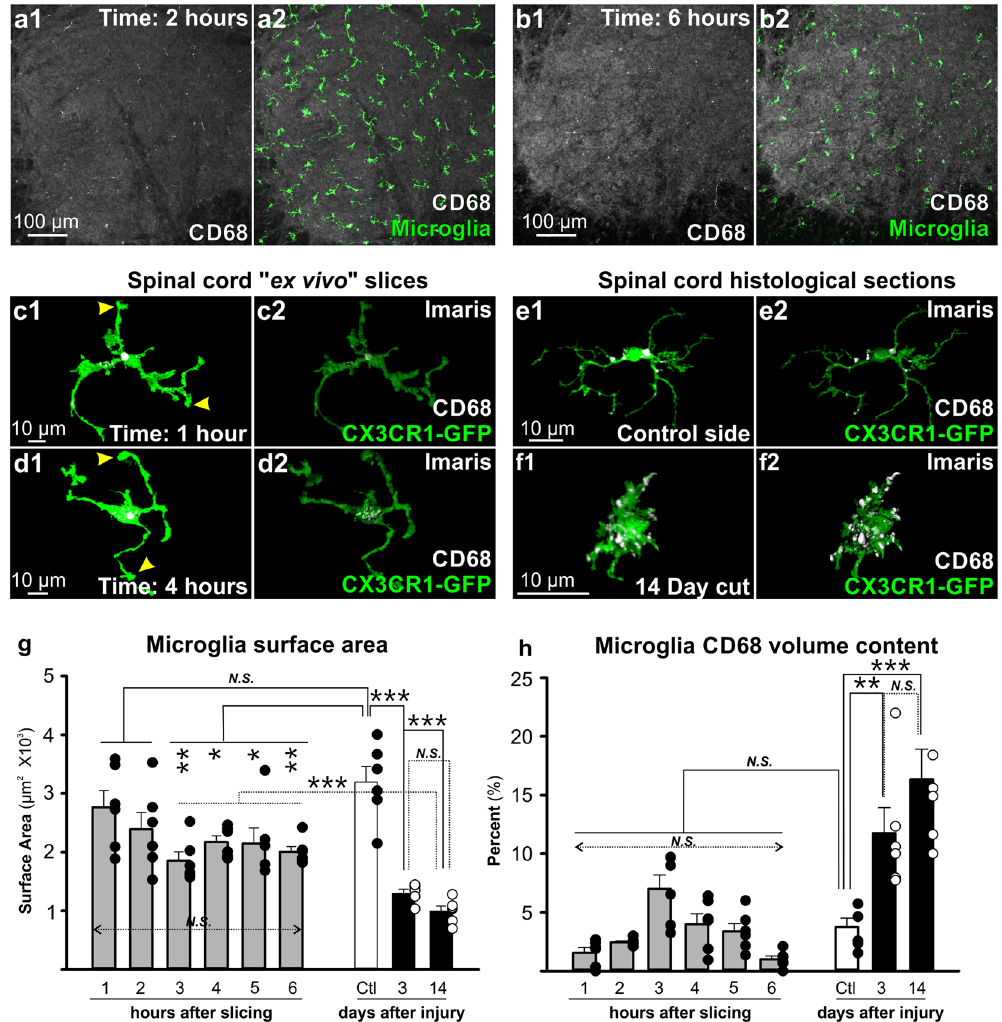
Figure 2. Validation of the slice preparation. ( a,b ) Low magnification confocal images of 50 µ m thick optical stacks sampled > 100 µ m away from the section cut surface in 350 μ m-thick spinal cord slices fixed at 2 ( a ) and 6 hours ( b ) after slicing (50 µ m thick optical stacks sampled > 100 µ m away from the section cut surface). CD68 is in white and CX3CR1-GFP in green. ( c,d ) High magnification confocal images of single microglia (green) and CD68 content (white) 1 hour ( c ) and 4 hours after slicing ( d ). Each cell is shown as a 2D projection of the optical image stack ( c1,d1 ) and in the Imaris 3D volume reconstruction ( c2,d2 ). Processes of microglia in slices sometimes display club-like endings (yellow arrowheads). ( e,f ) High magnification confocal images of microglia from perfusion-fixed spinal cord sections in the control (contralateral, e1,2 ) and injured sides (ipsilateral, f1,2 ) 14 days after sciatic transection. Ipsilateral to the injury microglia have shorter processes, increased cell volume and higher CD68 content. ( g ) Average microglia surface area at different times after slicing (grey bars, n = 6 cells per time point, error bars = SE). No significant differences (N.S.) were detected among microglia collected at different times after slicing, but when compared with control (Ctl) perfusion-fixed microglia (white bar, n = 6 cells) significant differences were detected with microglia sampled from slices cut 3 to 6 hours before fixation ( * p < 0.05, ** p < 0.01). Microglia ipsilateral to the injury (black bars) showed large decreases in total surface area at 3 and 14 days after the injury (n = 6 cells per time point) and these were significant when compared to control and also to microglia 1 to 6 hours after slicing ( *** p < 0.001). ( h ) Percent of cell volume occupied by CD68 immunoreactivity within single microglia. There were no differences in CD68 content in uninjured animals at any time point after slicing, and CD68 content was similar to microglia from the control side of perfusion-fixed spinal cord sections. CD68 content significantly increased in microglia 3 and 14 days after injury ( * p < 0.05, *** p <